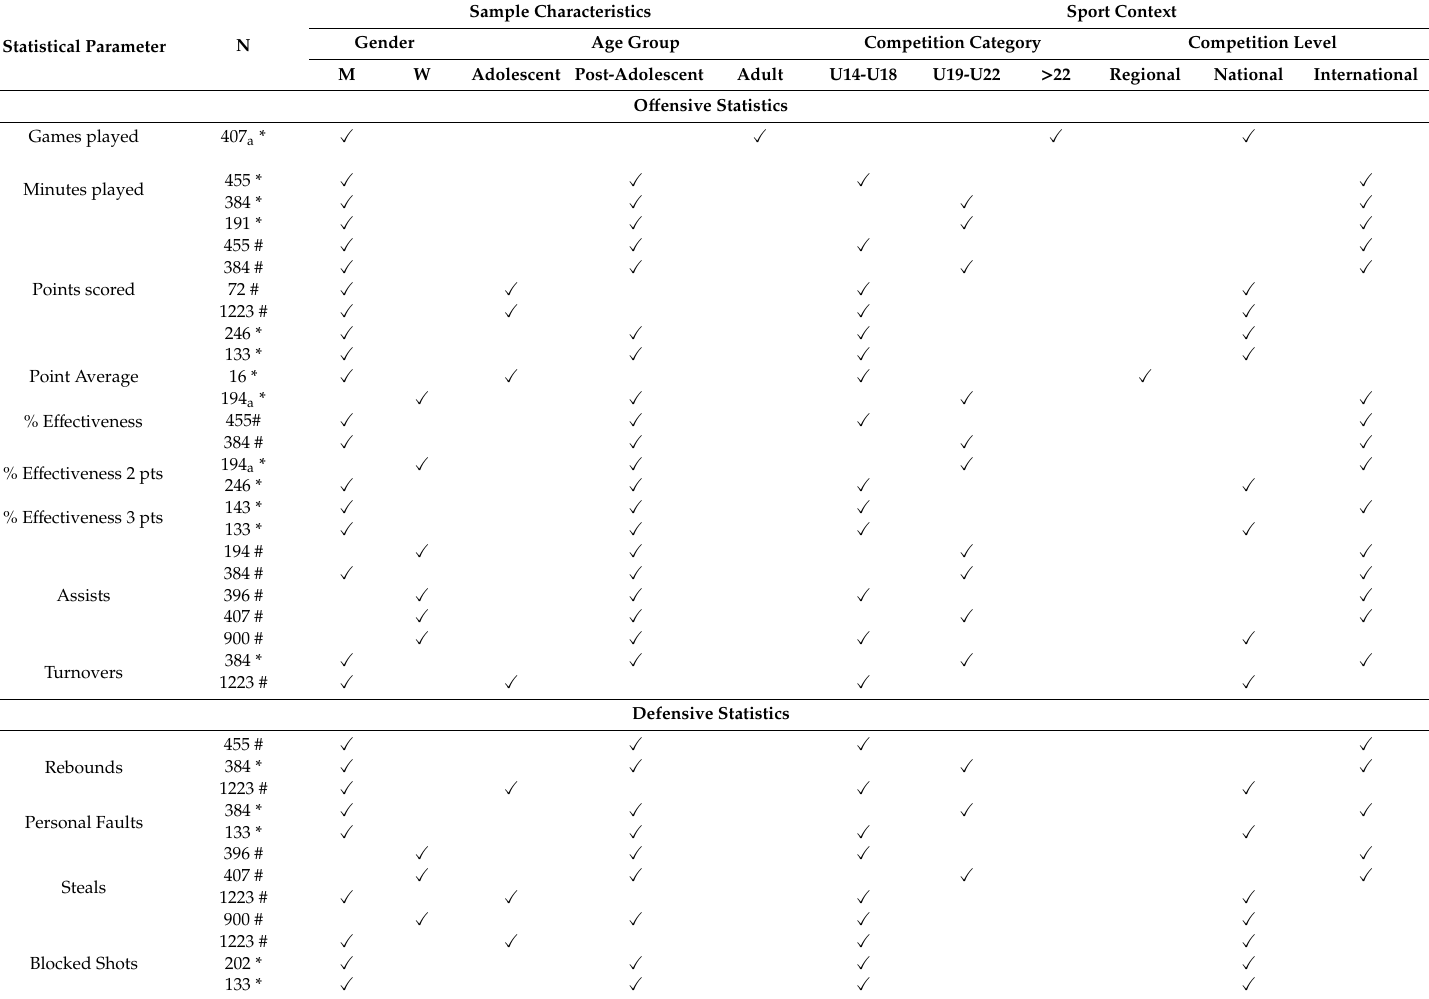
Table 5. Impact of the relative age e ff ect (RAE) on the o ff ensive and defensive individual performance statistical parameters (number of basketball players) according to the sample characteristics (gender and age group) and the sport context (competition category and competition level).